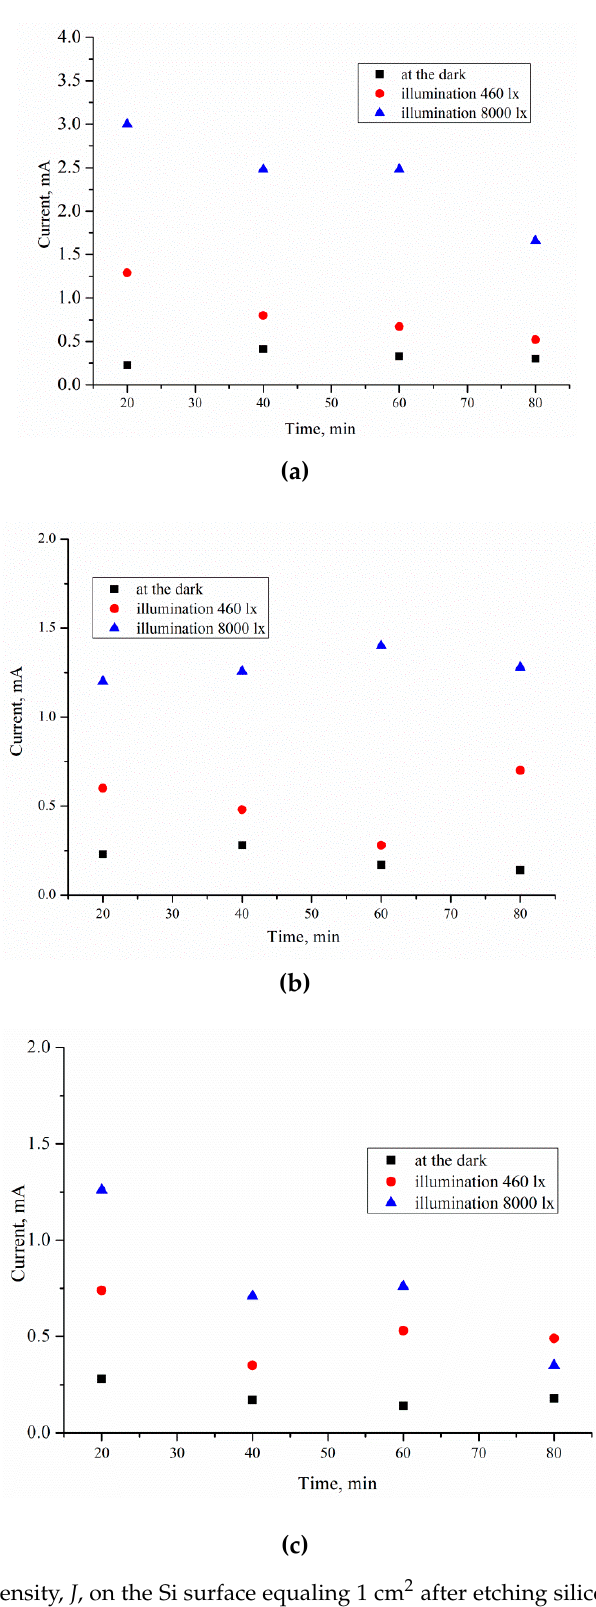
Figure 3. Current density, J , on the Si surface equaling 1 cm 2 after etching silicon with: ( a ) ρ = 0.01, ( b ) 1, ( с ) and 12 Ω ·cm.